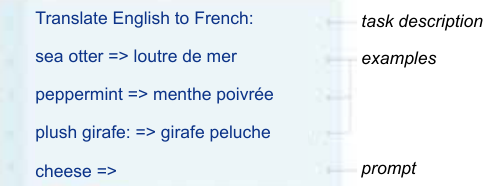
Figure 3 GPT-3 using few-shot learning for English to French translation. In-context learning is a concept introduced by GPT-3, which leads to the idea of prompt learning. Rather than changing parameters for different tasks, the model can use the inputs and outputs of the tasks as prompts, and generate predictions based on the test set inputs. The user guides the GPT- 3 model to learn this “thinking style” by giving questions and answers related to the questioning style to the GPT-3 model, so that when solving similar problems in real situations, they can start to answer questions along the user desired thinking path